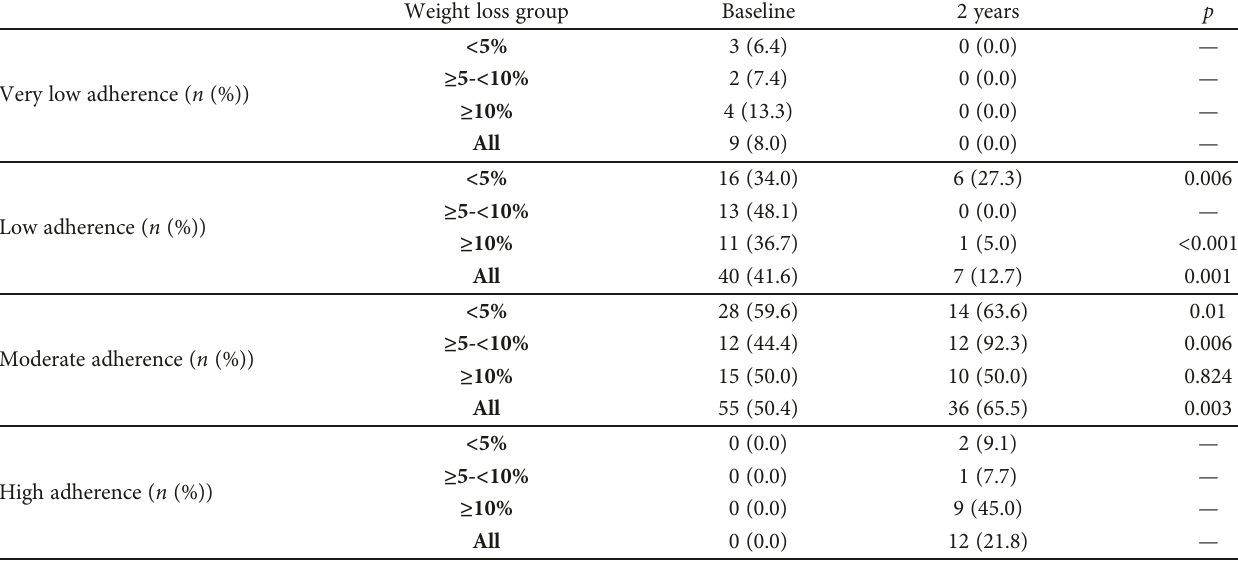
Table 2: Adherence to Mediterranean diet at baseline ( n = 115 MHO participants) vs. after 2 years ( n = 67 MHO participants) of lifestyle modi fi cation, according to percentage of weight loss.